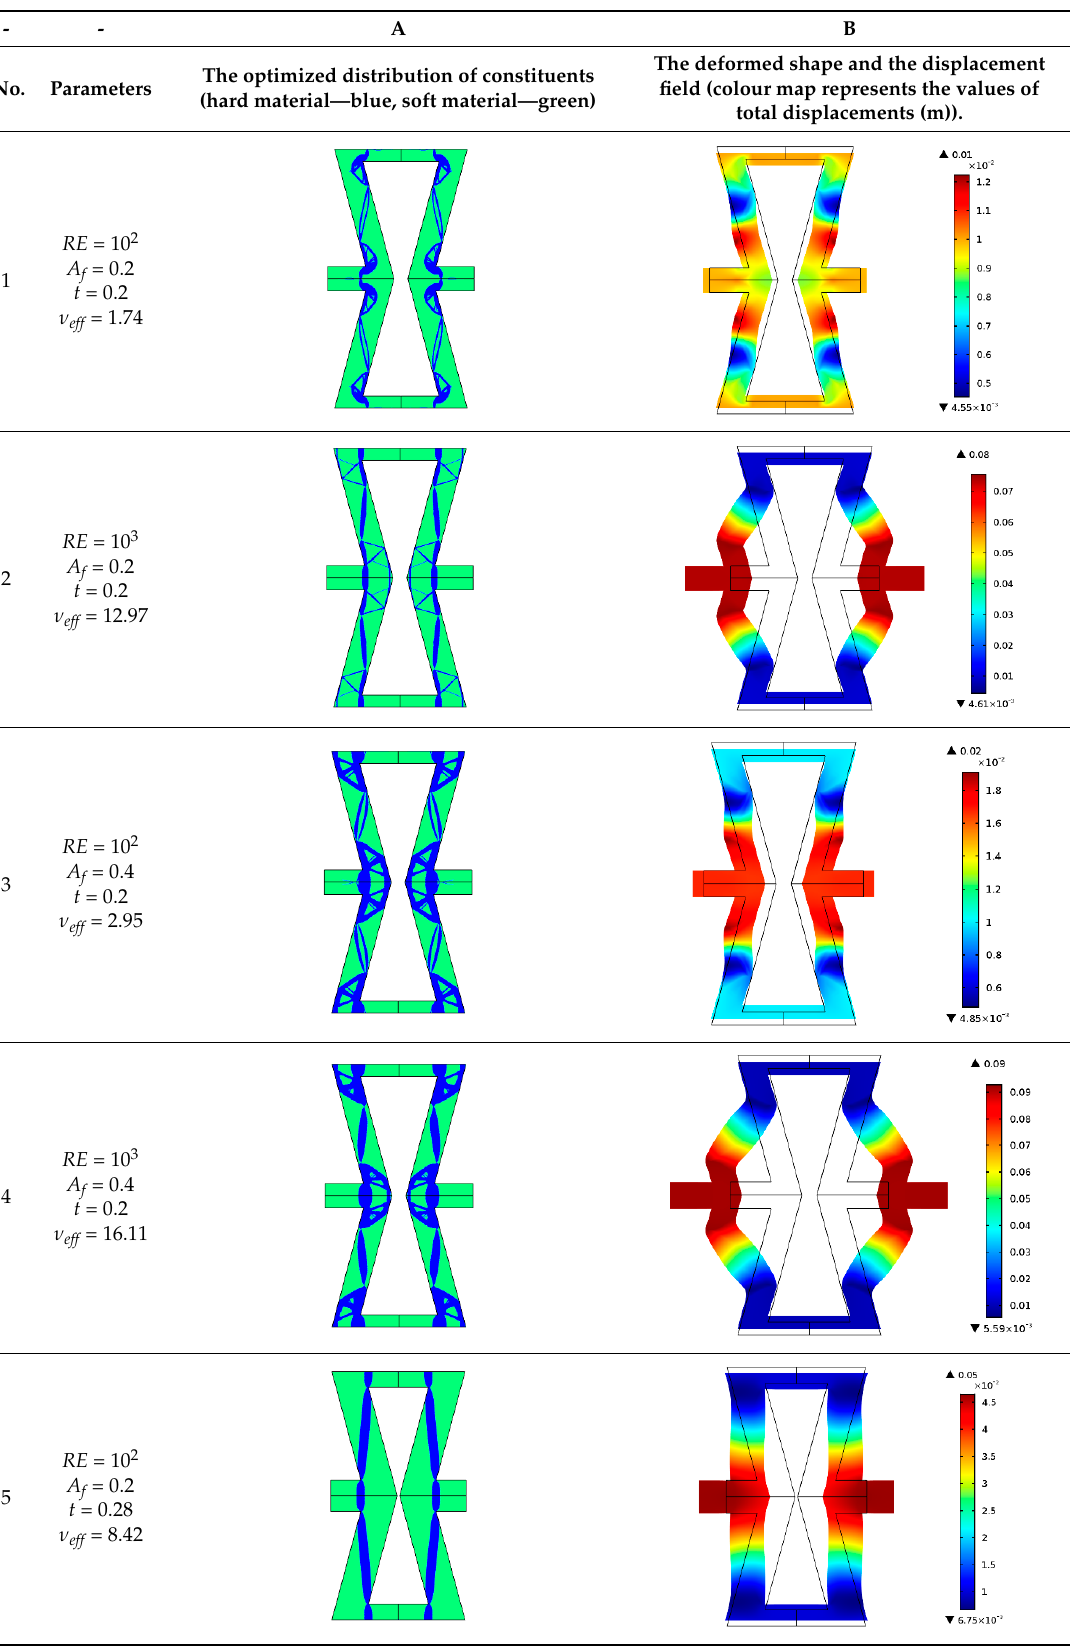
Table 3. Results of re-entrant honeycomb topology optimization. Parameters of each case, the optimized distribution of constituents, and the deformed shape of a vertically compressed shape.